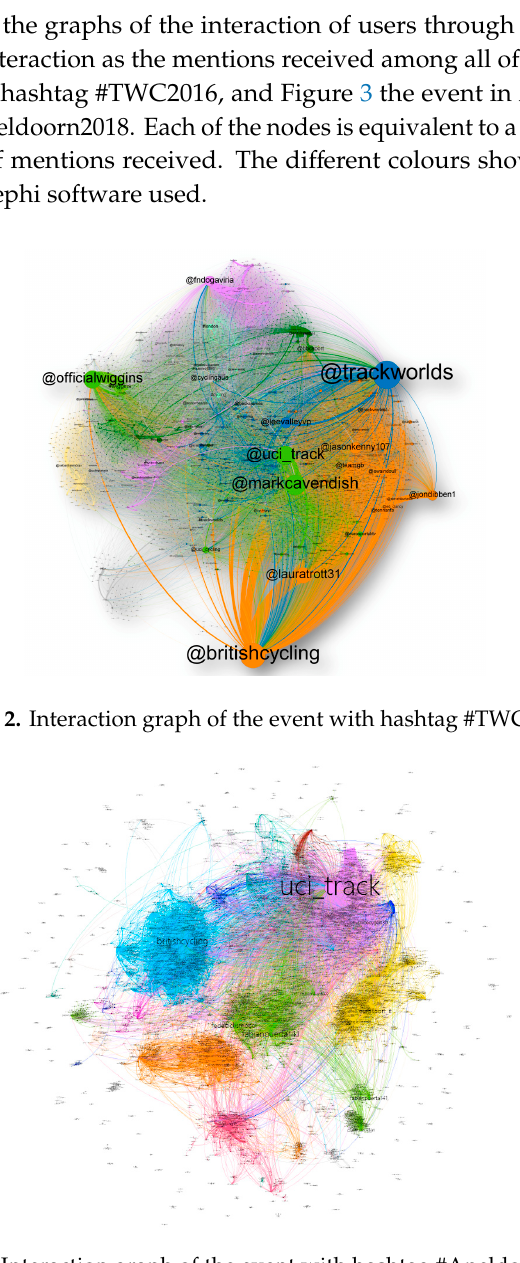
Figure 3. Interaction graph of the event with hashtag #Apeldoorn2018.